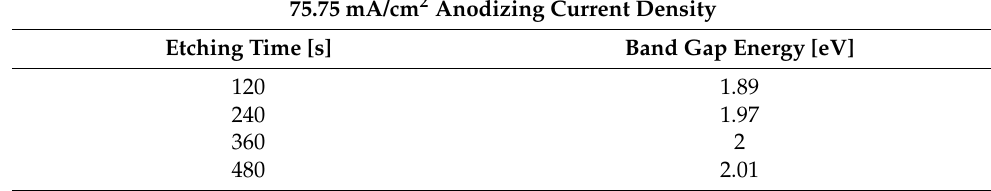
Table 2. Energy values [eV] of the band gap of PSi layers.